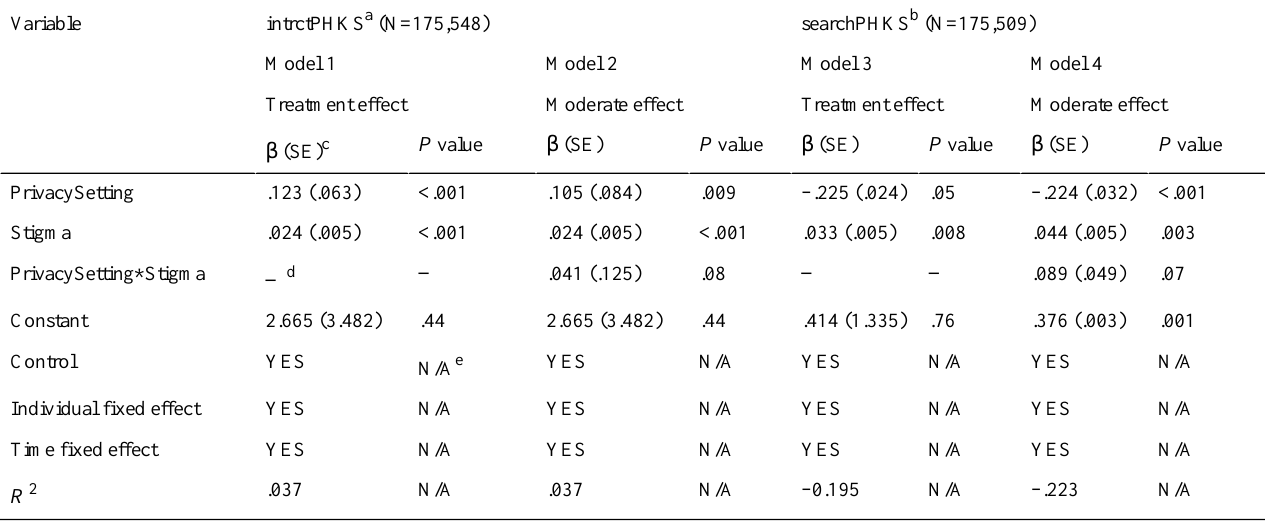
Table 4. Econometric models of the treatment effect and moderate effect. All the control variables and the individual and time fixed effect variables were included in the 4 models. The interaction terms (PrivacySetting*Stigma) represent the moderate effect of stigma.